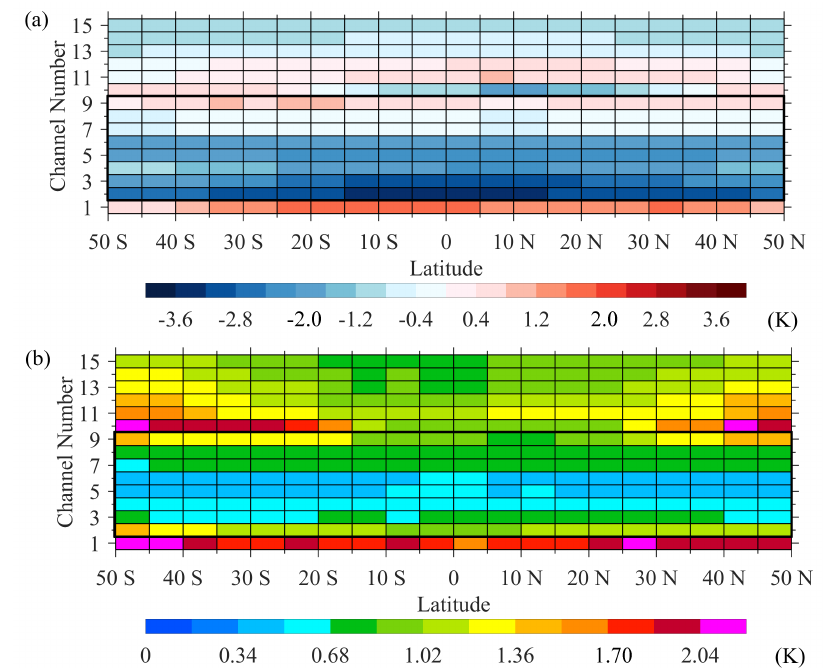
Figure 8. Latitudinal dependence values of the: ( a ) biases (unit: K); and ( b ) standard deviations (unit: K) of the “O − B” calculated in each 5 ◦ latitudinal band between 50 ◦ S and 50 ◦ N. The black box represents the 118-GHz